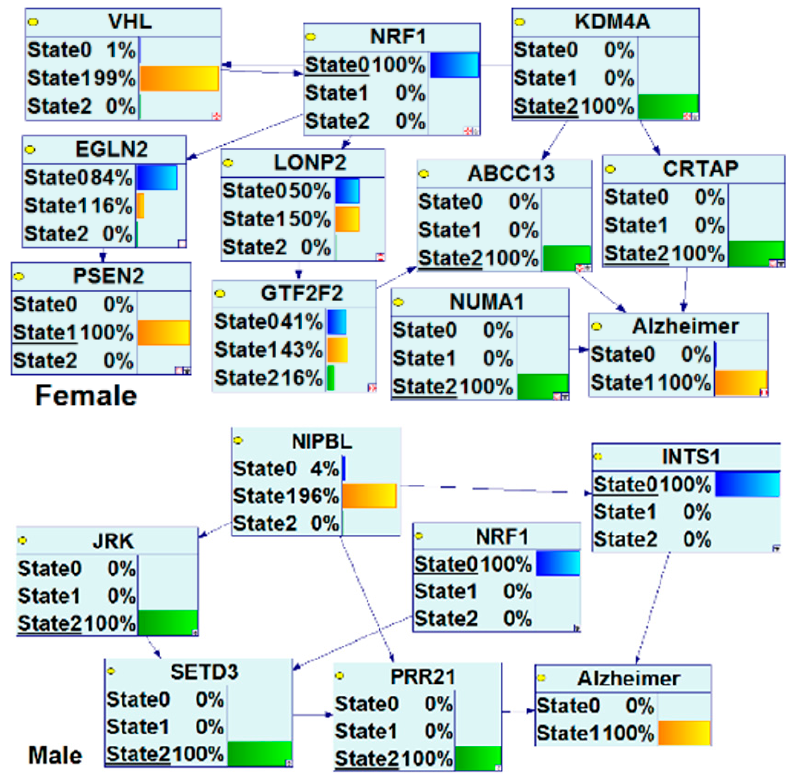
Figure 11. Gender differences in NRF1 network in AD of brain microarray data of 79 subjects of male (15 AD patients, 17 control) and female (17 AD patients, 30 controls) from GEO database [272].